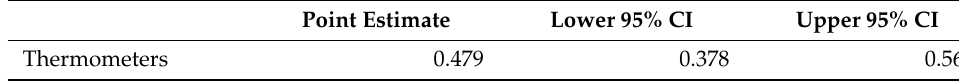
Table 9. Interclass correlation among the four thermometers.